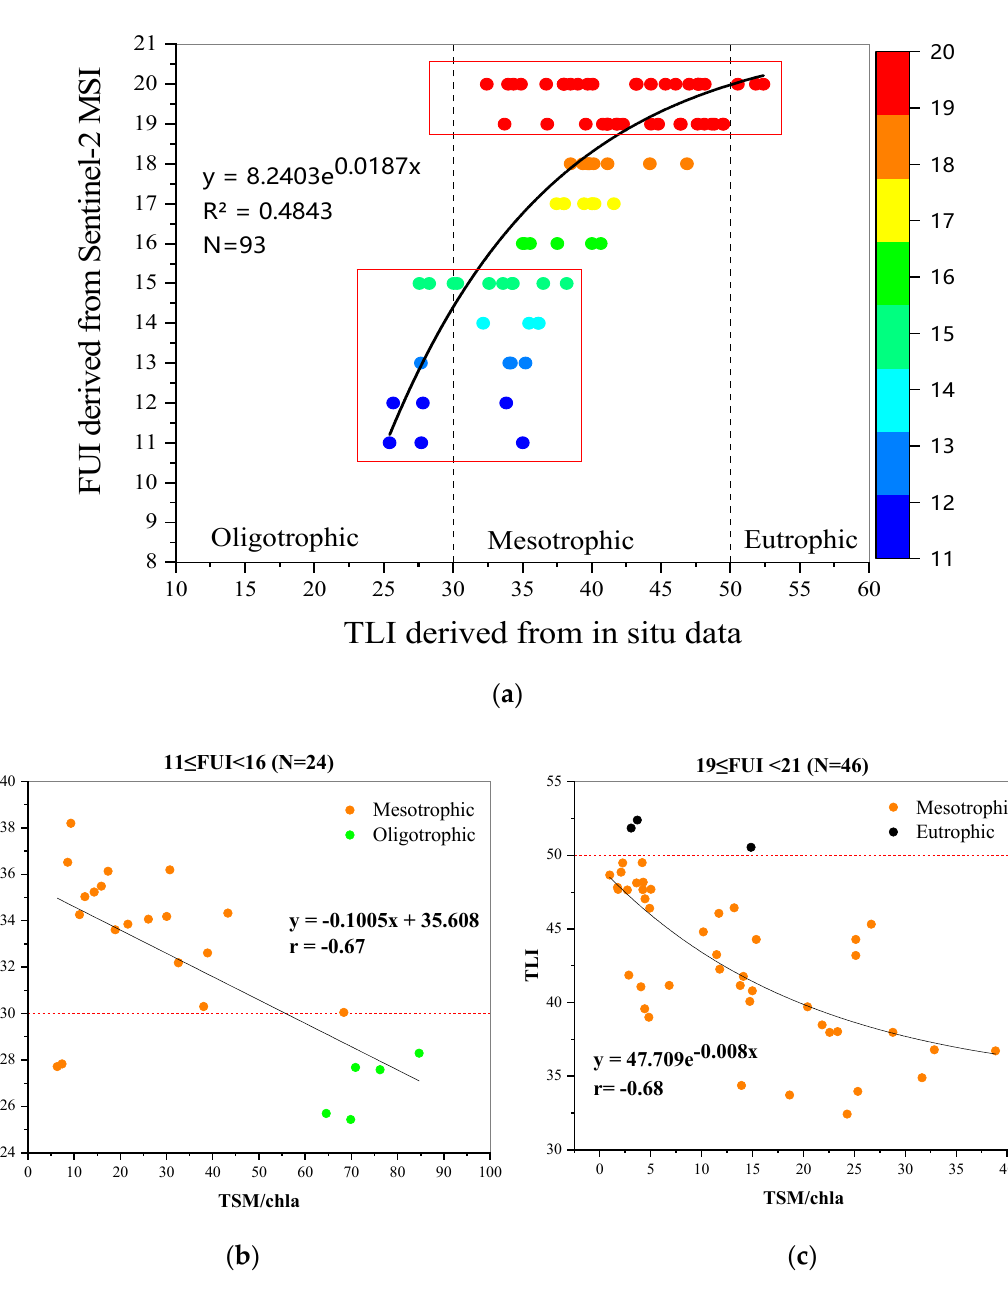
Figure 7. ( a ) Relationships between FUI and TLI from the in situ experiment data set. ( b , c ) Relationships between TSM/Chl-a and trophic level index (TLI) when FUI is between 11 and 15 and between 19 and 20.